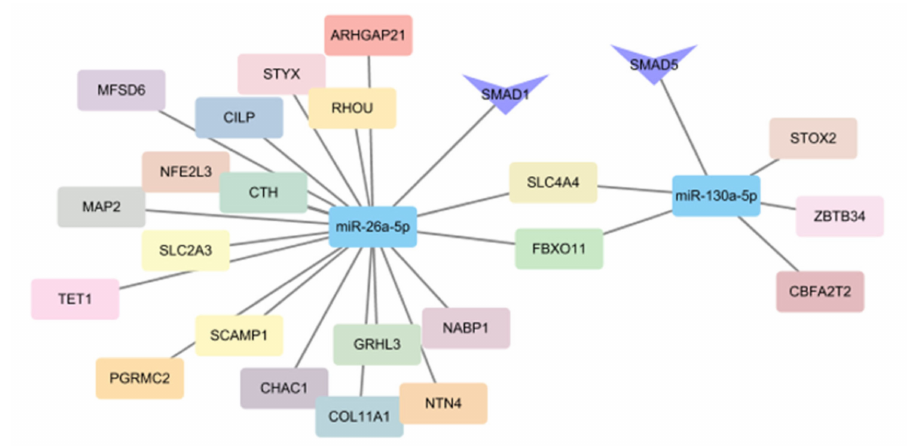
Figure 6. The miRNA − mRNA network associated with sheep wool curvature, showing the interactions among miR-26a, miR-130a and their target genes.